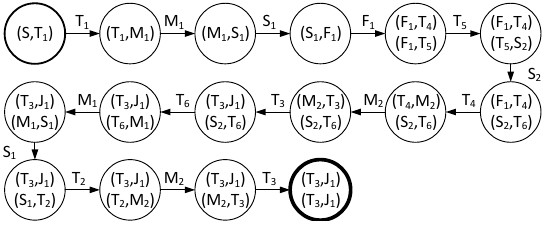
Figure 30. SESE decomposition of the example workflow